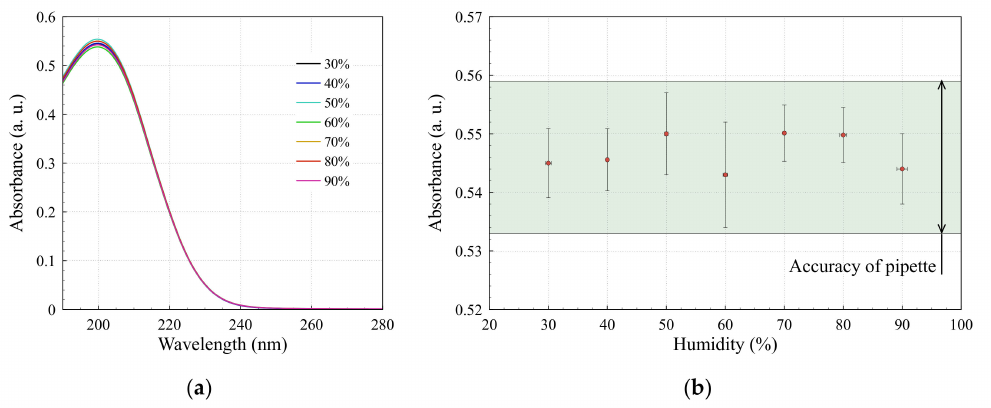
Figure 5. ( a ) DUV absorption spectra and ( b ) intensity of absorption peak at 200 nm of DI water treated with AAGD at various humidity